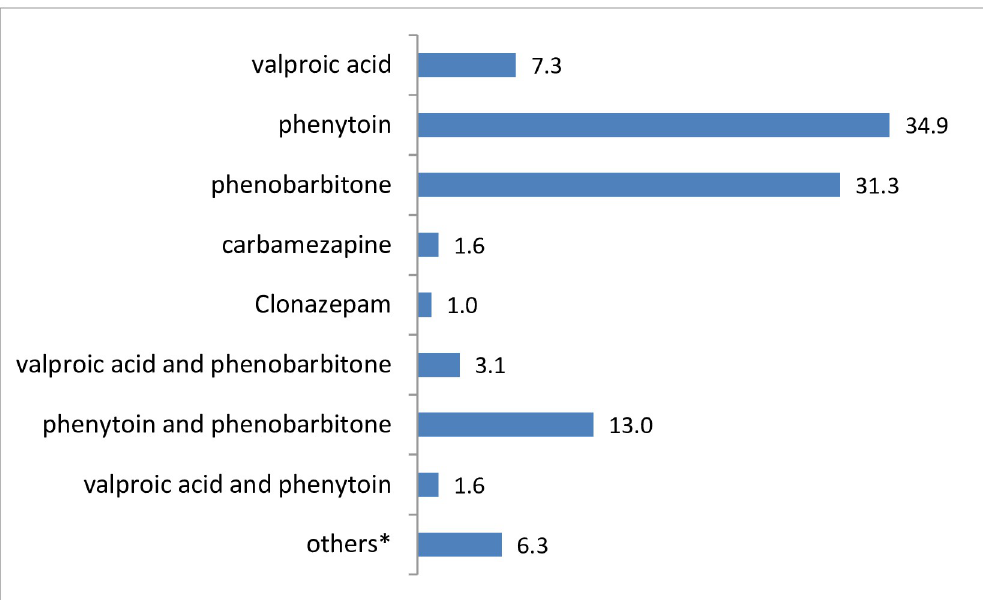
Fig 1. Percentage distribution of commonly prescribed AEDs. � Valproic acid and clonazepam (n = 2); phenobarbitone and carbamazepine (n = 2); lamotrigine(n = 2); Valproic acid, phenobarbitone and clonazepam(n = 2); phenytoin and carbamazepine(n = 2), Valproic acid, carbamazepine and clonazepam(n = 1).